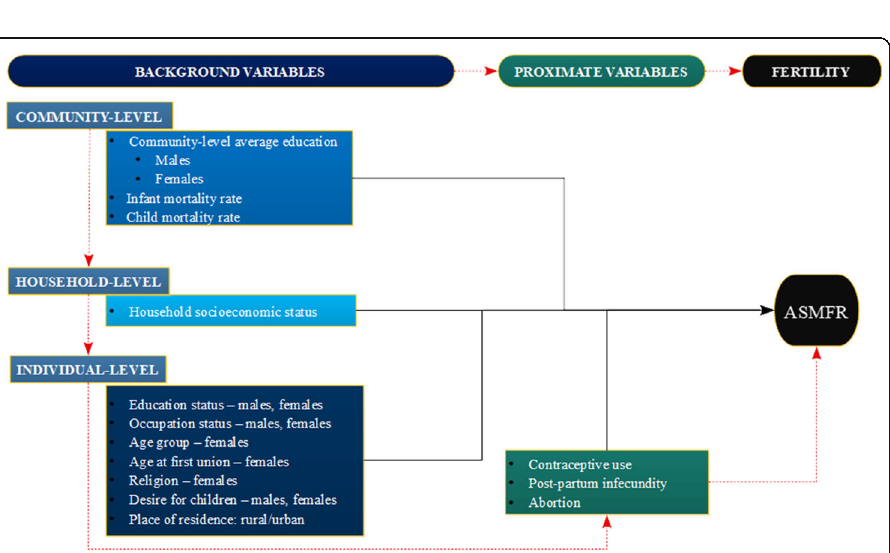
Fig. 1 Conceptual framework adapted from the DTT, ideational change and PD